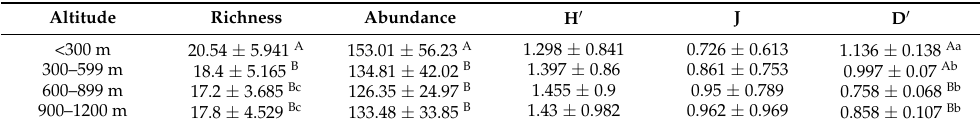
Table 2. The bird diversity index in different altitude gradient (capital letter is p < 0.01; lowercase letter is p < 0.05). H (cid:48) is Shannon–Wiener diversity index; J is Pielou evenness index; D (cid:48) is Margalef abundance index.